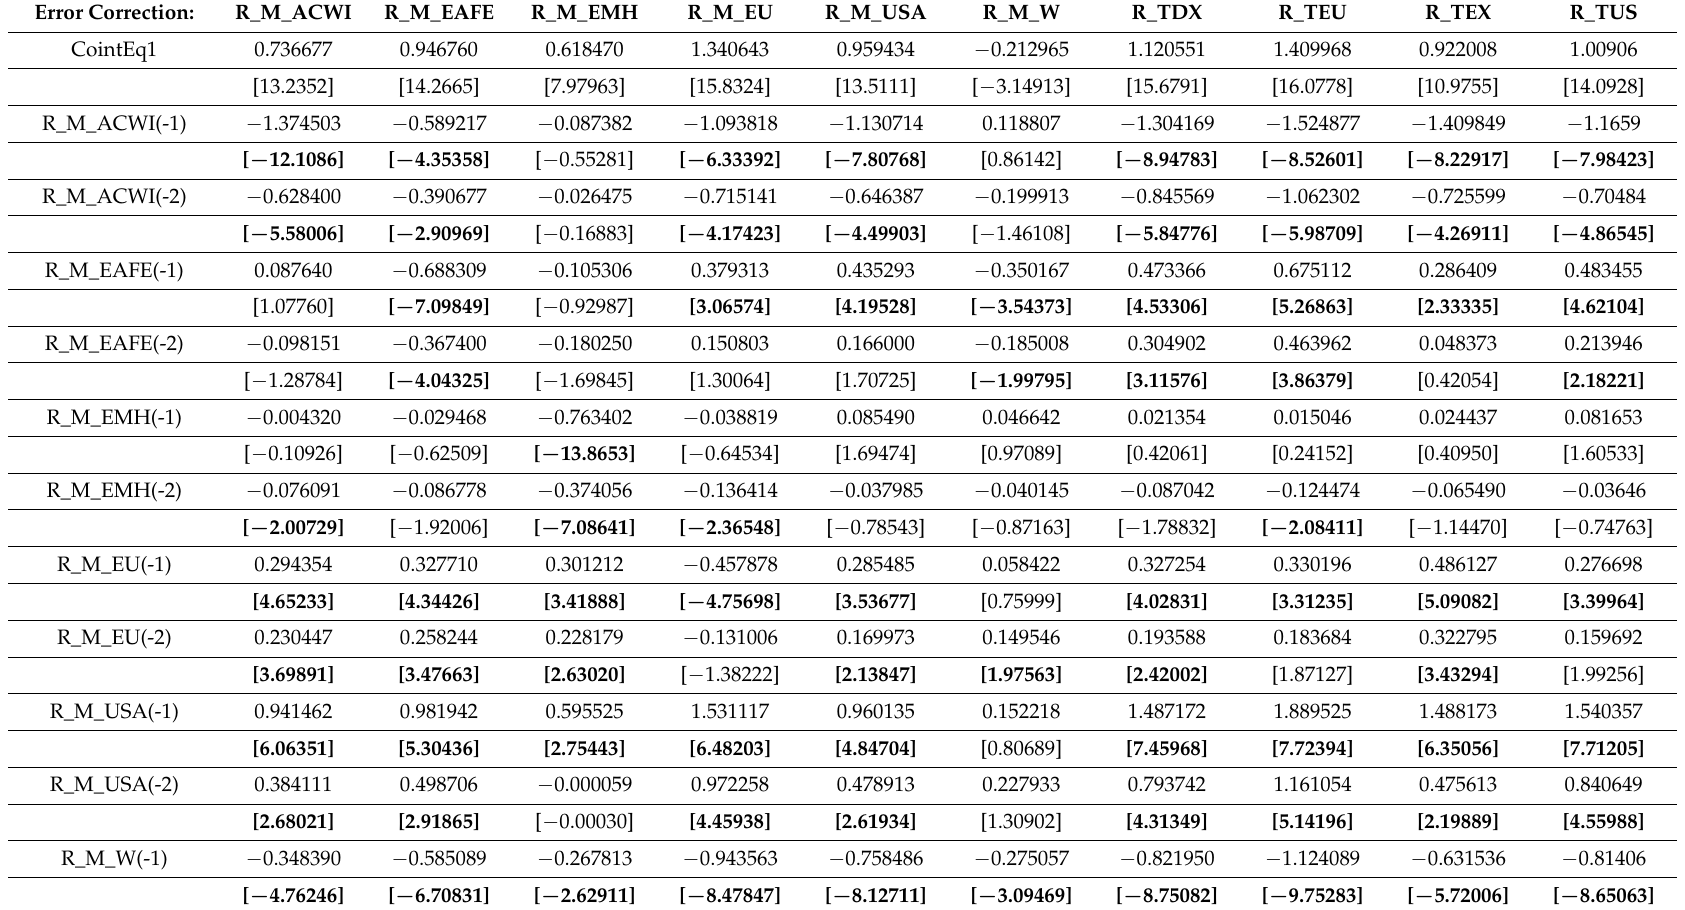
Table 6. Results from vector error correction model applied for conventional and sustainable analysis